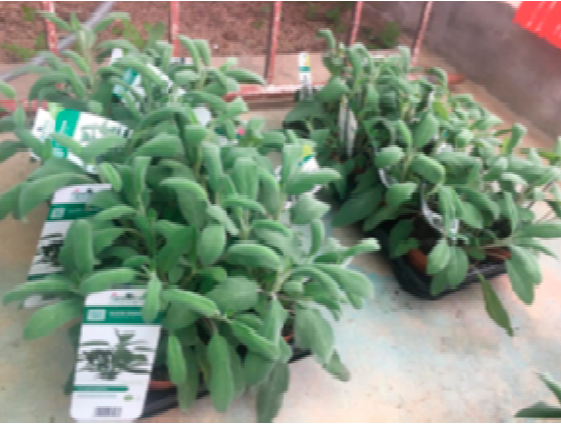
Figure 1. Young plants of Salvia officinalis L. grown in pots having diameter of 12 cm.